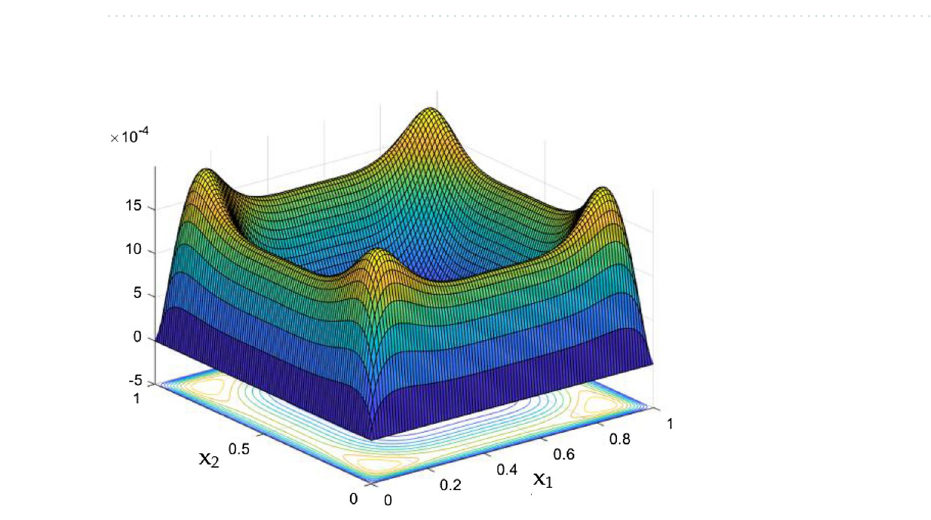
Figure 5. Velocity field for Ra = 0, in the absence of external MF.